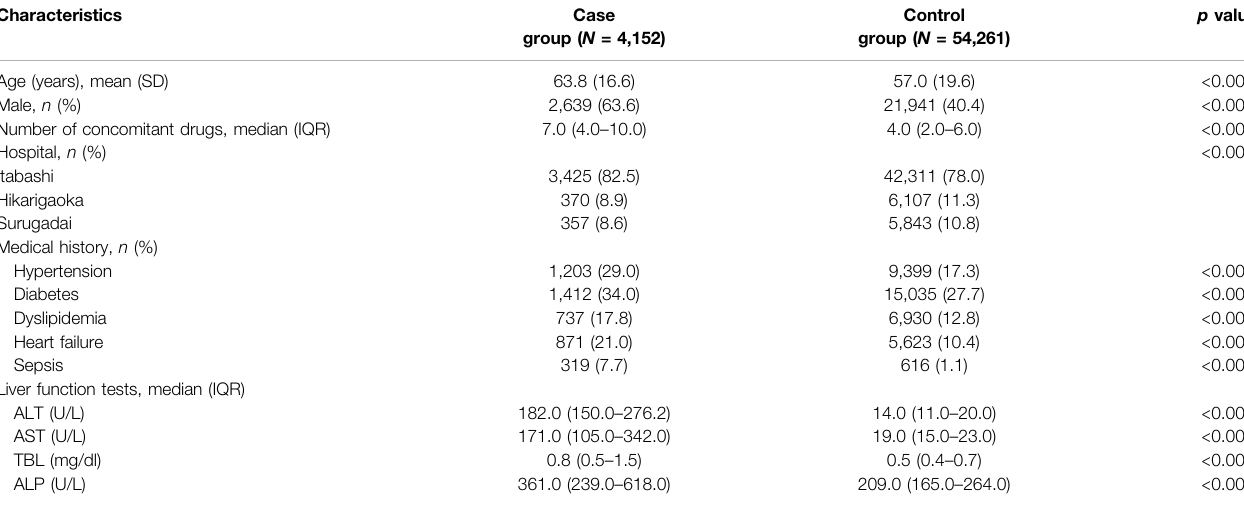
TABLE 1 | Patient characteristics in case and control groups.